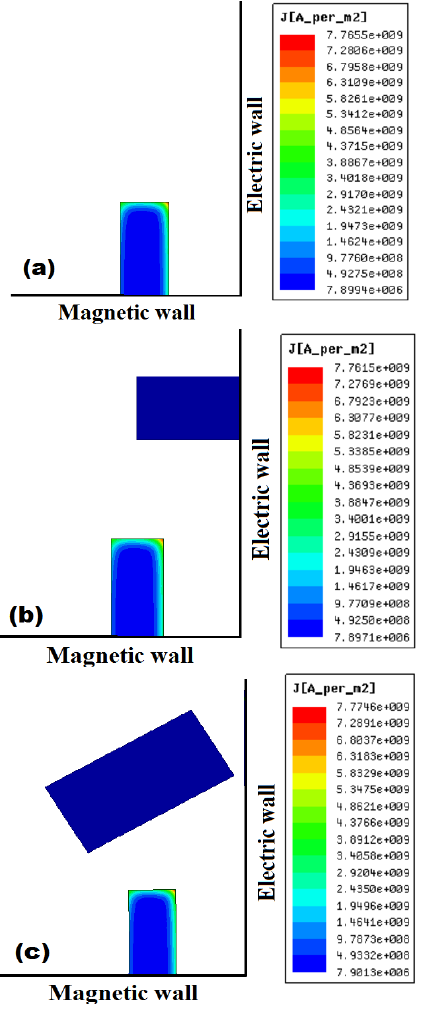
Figure 11: Current distributions on rail for: (a) conventional railgun (b) Augmented railgun with 2 magnets. (c) Augmented railgun with 4 magnets.